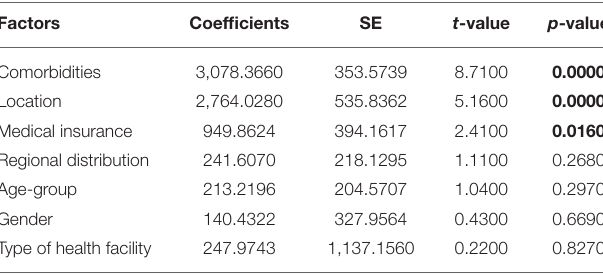
TABLE 3 | Regression coefficients and standard errors for major factors associated with hospitalization costs.